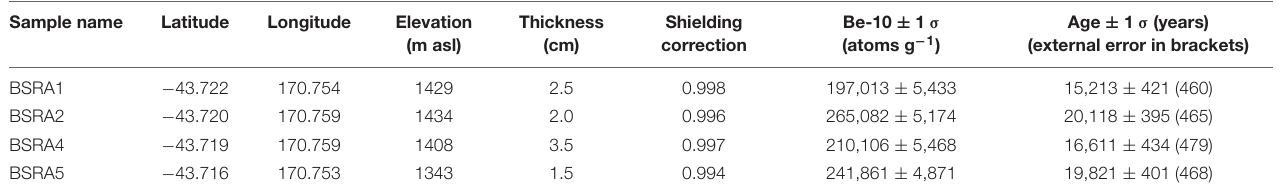
TABLE 1 | Cosmogenic 10 Be exposure age parameters and results. All samples were considered to have a density of 2.7 g cm − 1 , a typical value for greywacke, and measured with the same AMS standard,